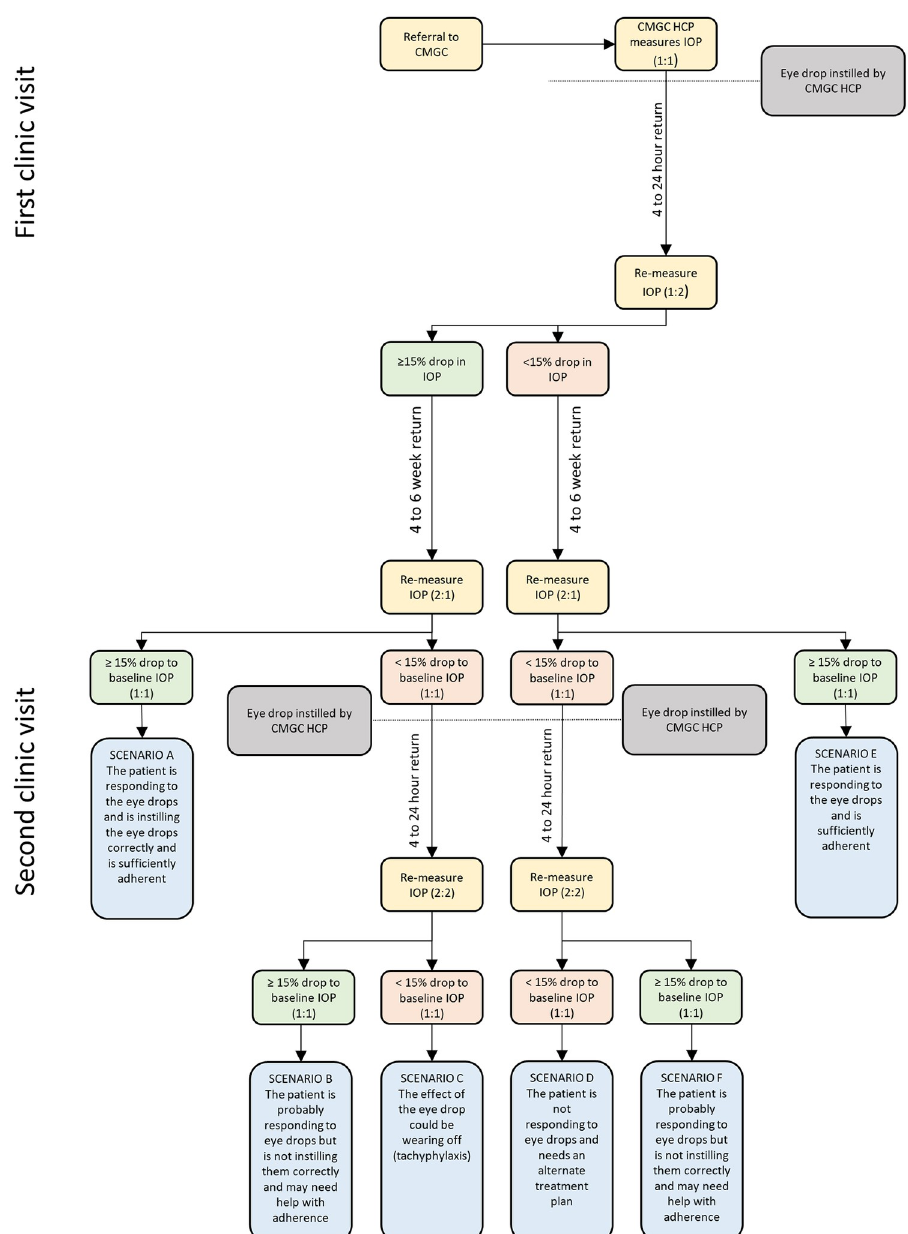
Fig 1. Final Cardiff Model of Glaucoma Care Algorithm